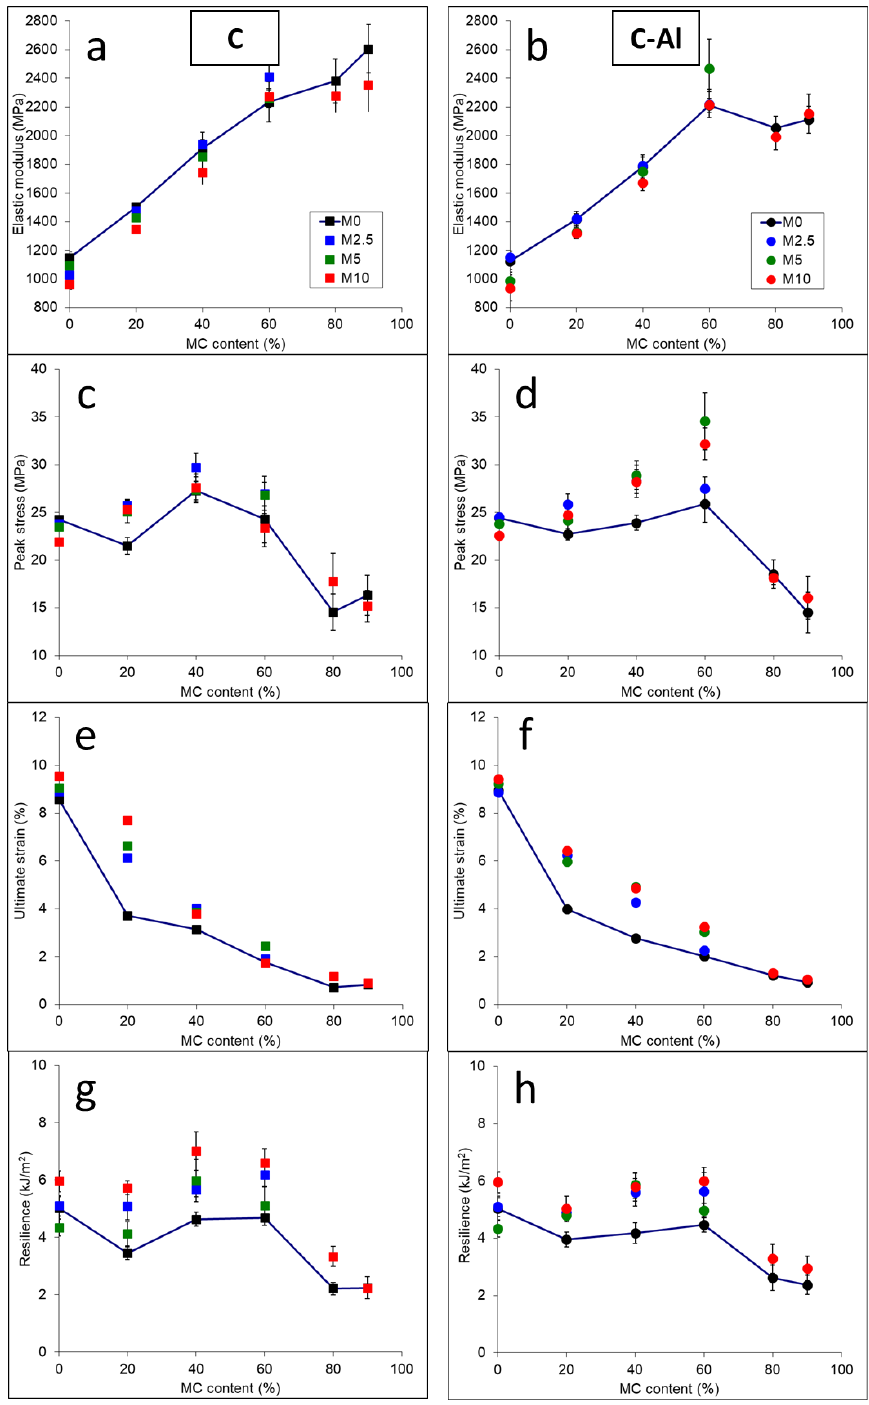
Figure 4. Tensile and impact parameters of the prepared composites as a function of composition: elastic modulus (a, b), peak stress (c, d), ultimate strain (e, f) and impact resilience (g, h). Lines connecting points of the M0Cx-CAlx systems are reported as a guide for the eye.